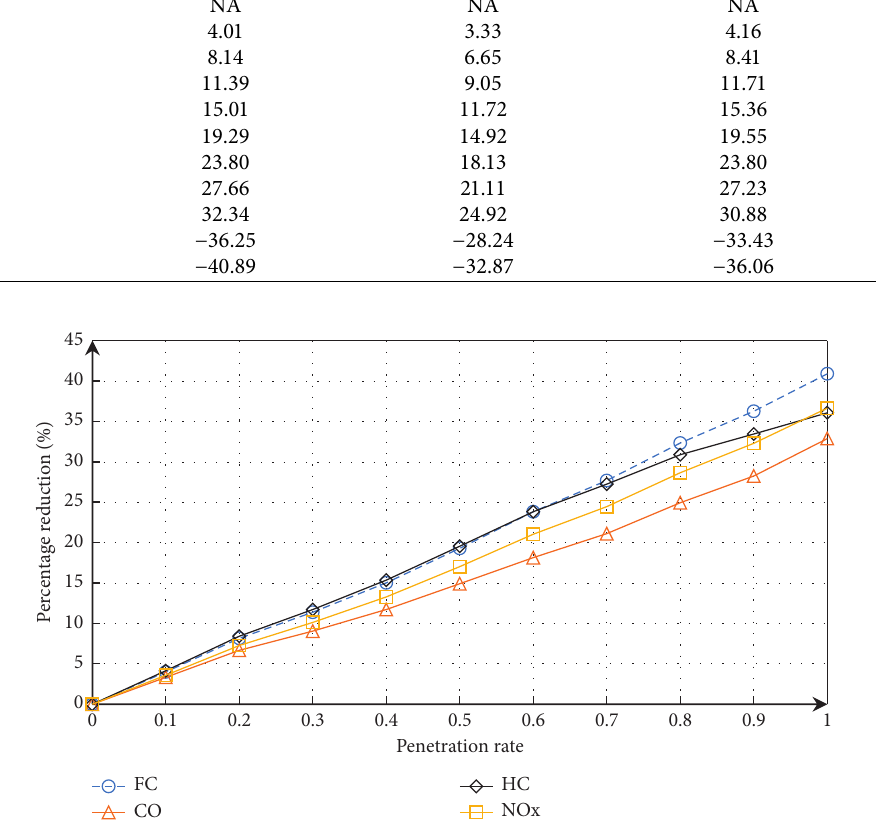
Figure 10: Percentage reduction in fuel consumption and traffic emissions (Scenario